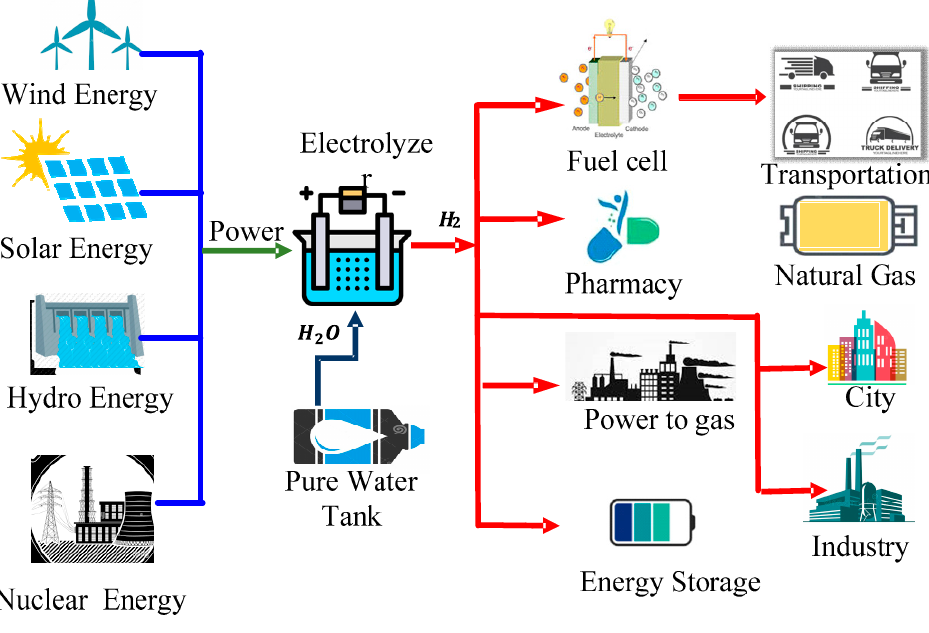
Figure 1. Applications of hydrogen energy